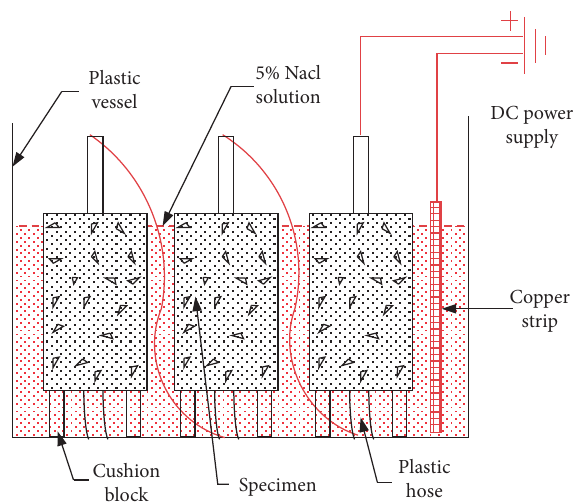
Figure 3: The schematic diagram of the electrochemical principle. Table 2: The measuring corrosion rate of